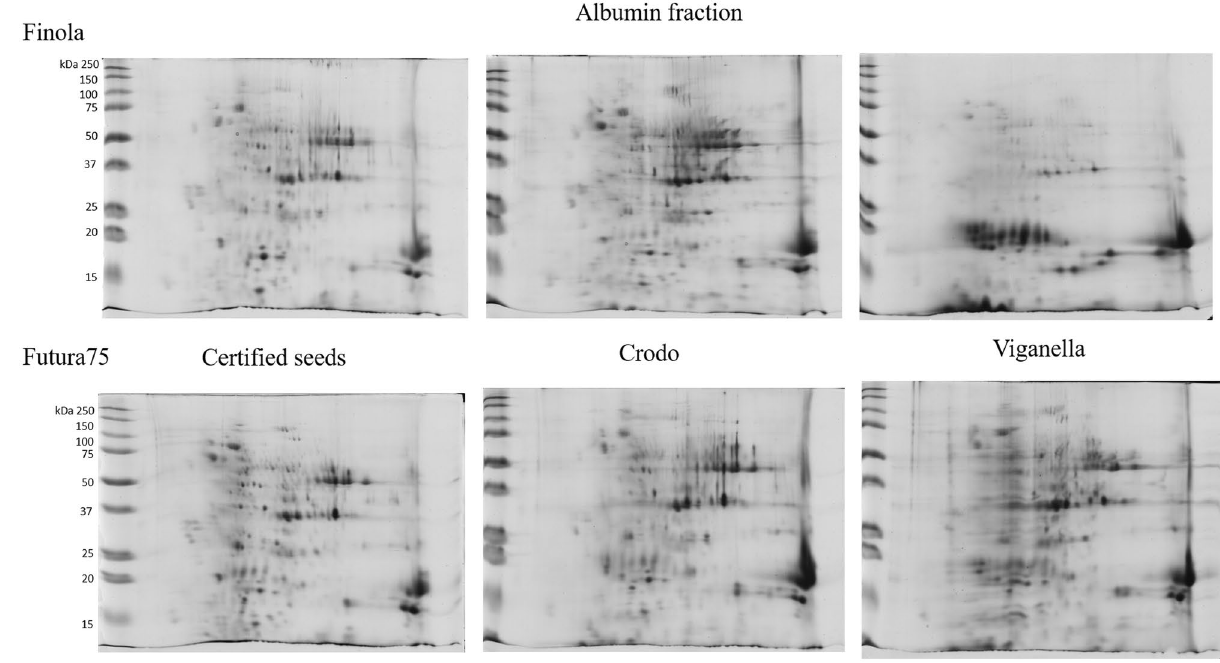
Figure 1. 2D-PAGE of albumin fraction of Finola (on the upper part of the image) and Futura 75 (on the lower part of the image) certified seeds (on the left), or obtained from the experimental fields of Crodo (middle) and Viganella (right).